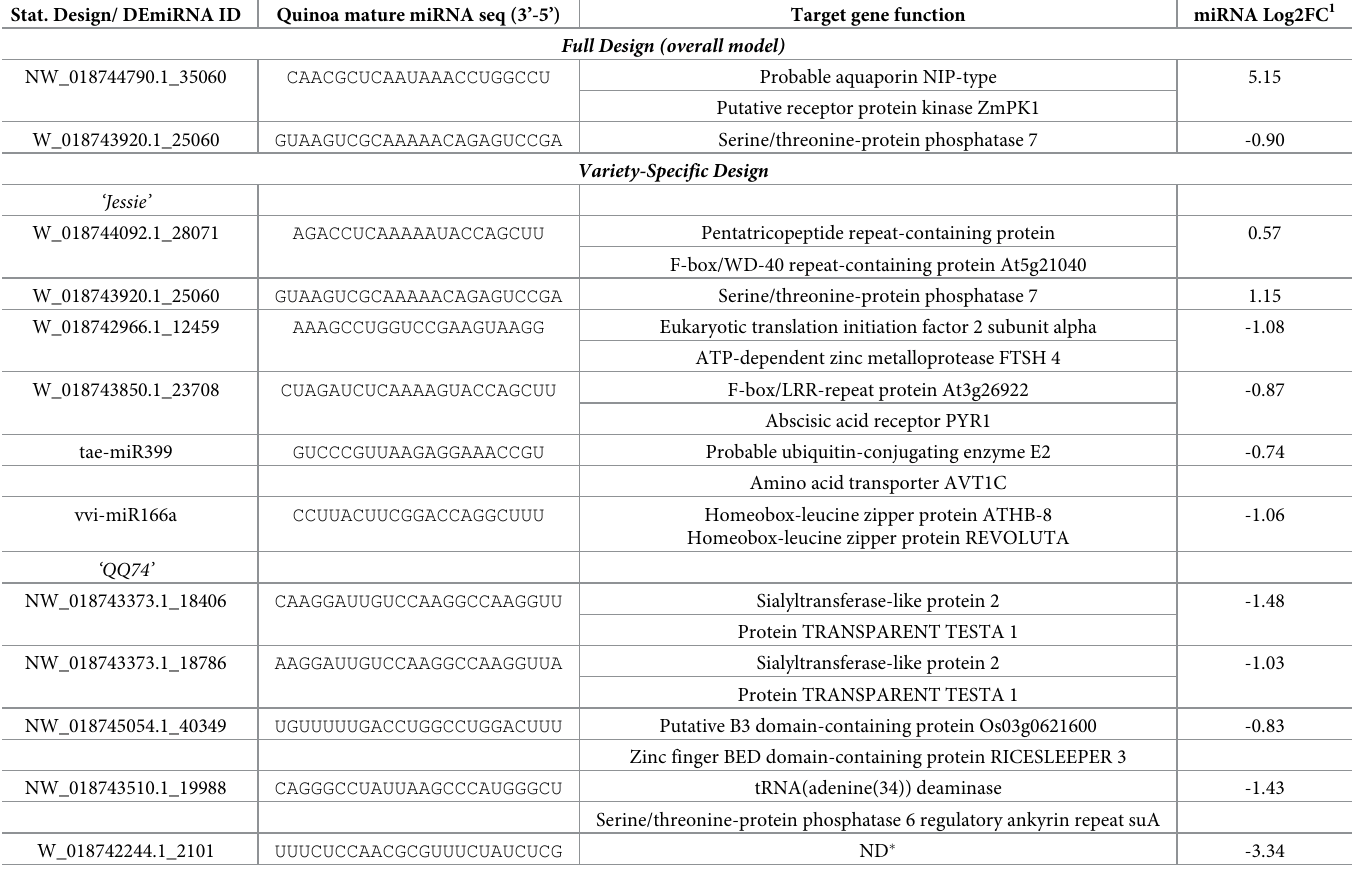
Table 3. Differentially expressed known and novel microRNAs (DEmiRNA) between cucumber mosaic virus-inoculated and mock-inoculated samples among and within quinoa varieties with their representative target